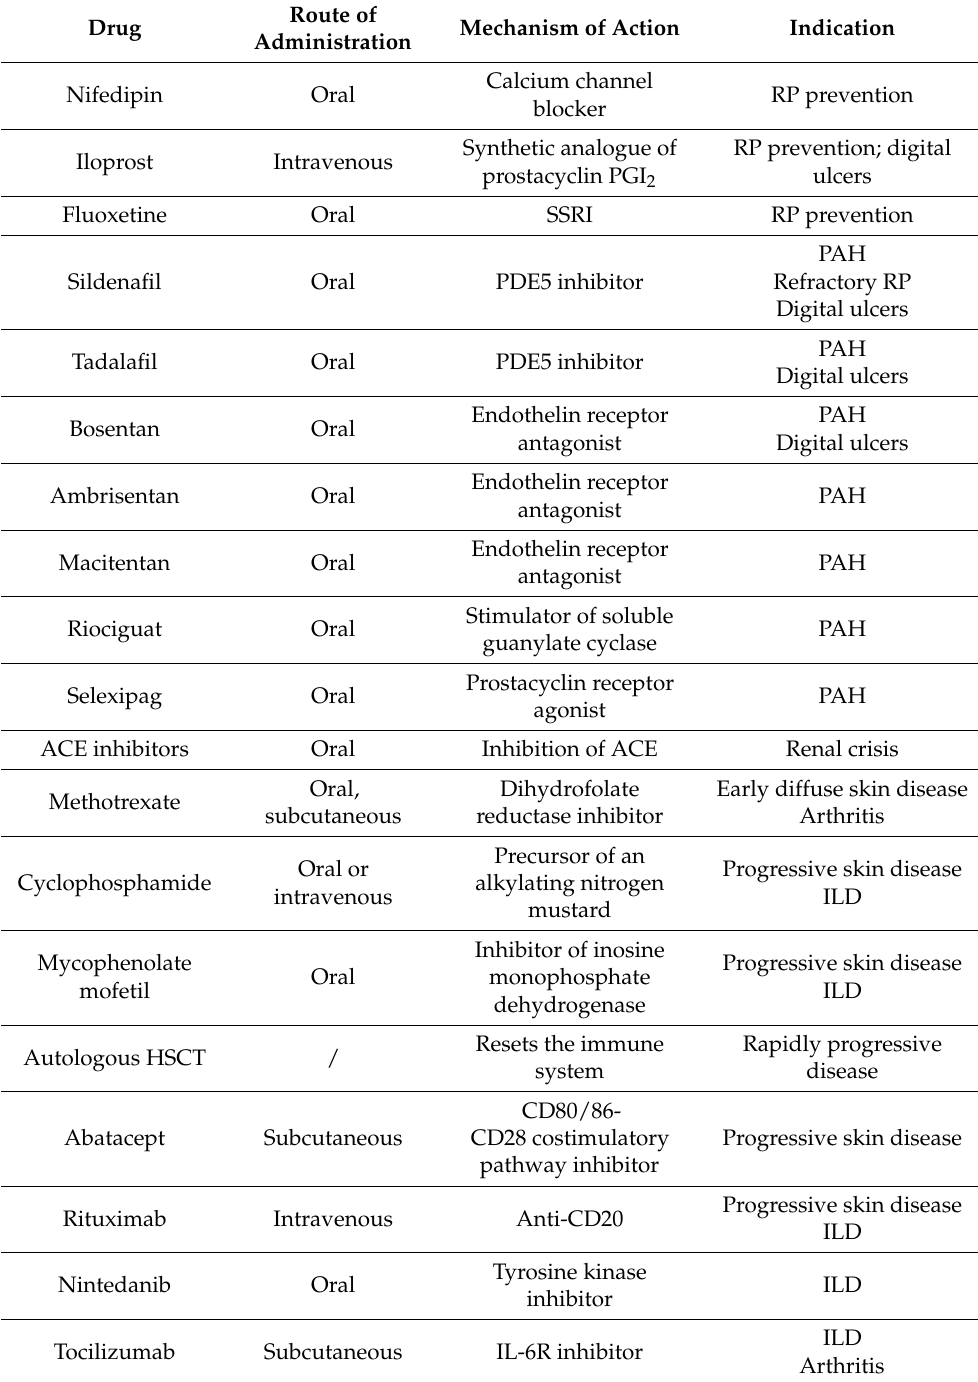
Table 2. Currently available treatment options for